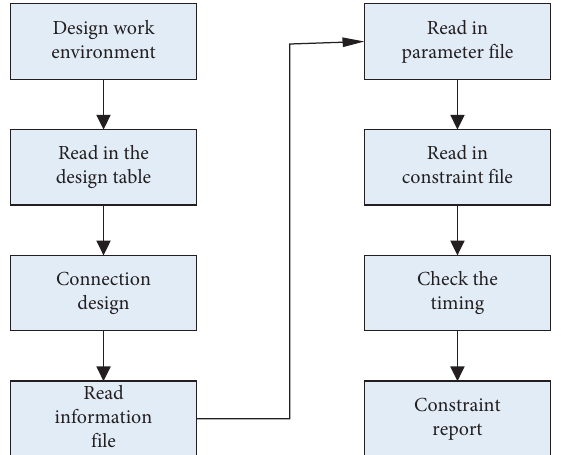
Figure 1: Flow of static timing constraints.